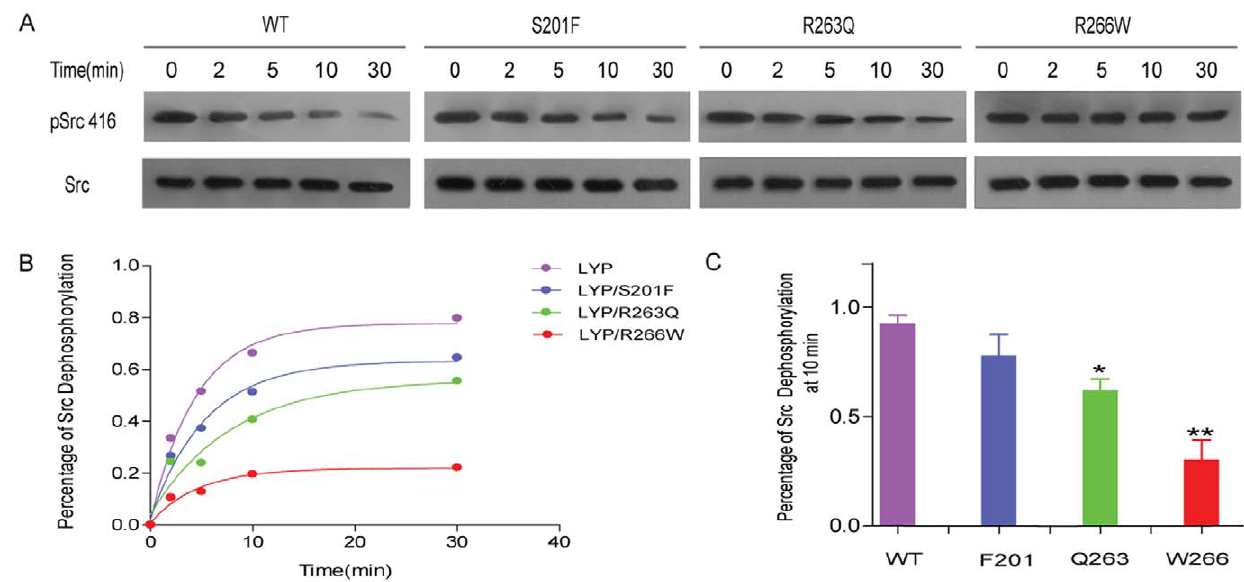
Figure 3. Dephosphorylation of pSrc416 by Lyp wild type and mutants. (A) Time dependence of pSrc416 dephosphorylation by Lyp wild type, S201F, R263Q and R266W. The phosphorylation level of the Src protein at 416 position was monitoted by Western blotting. (B) The dephosphorylation levels were quantified with Image J software, and plotted against the different time. (C) Statistical analysis of Lyp catalyzed pSrc416 dephosphorylation at 10 min. All experiments were repeated in triplicate. *P , 0.05; ** P , 0.01.